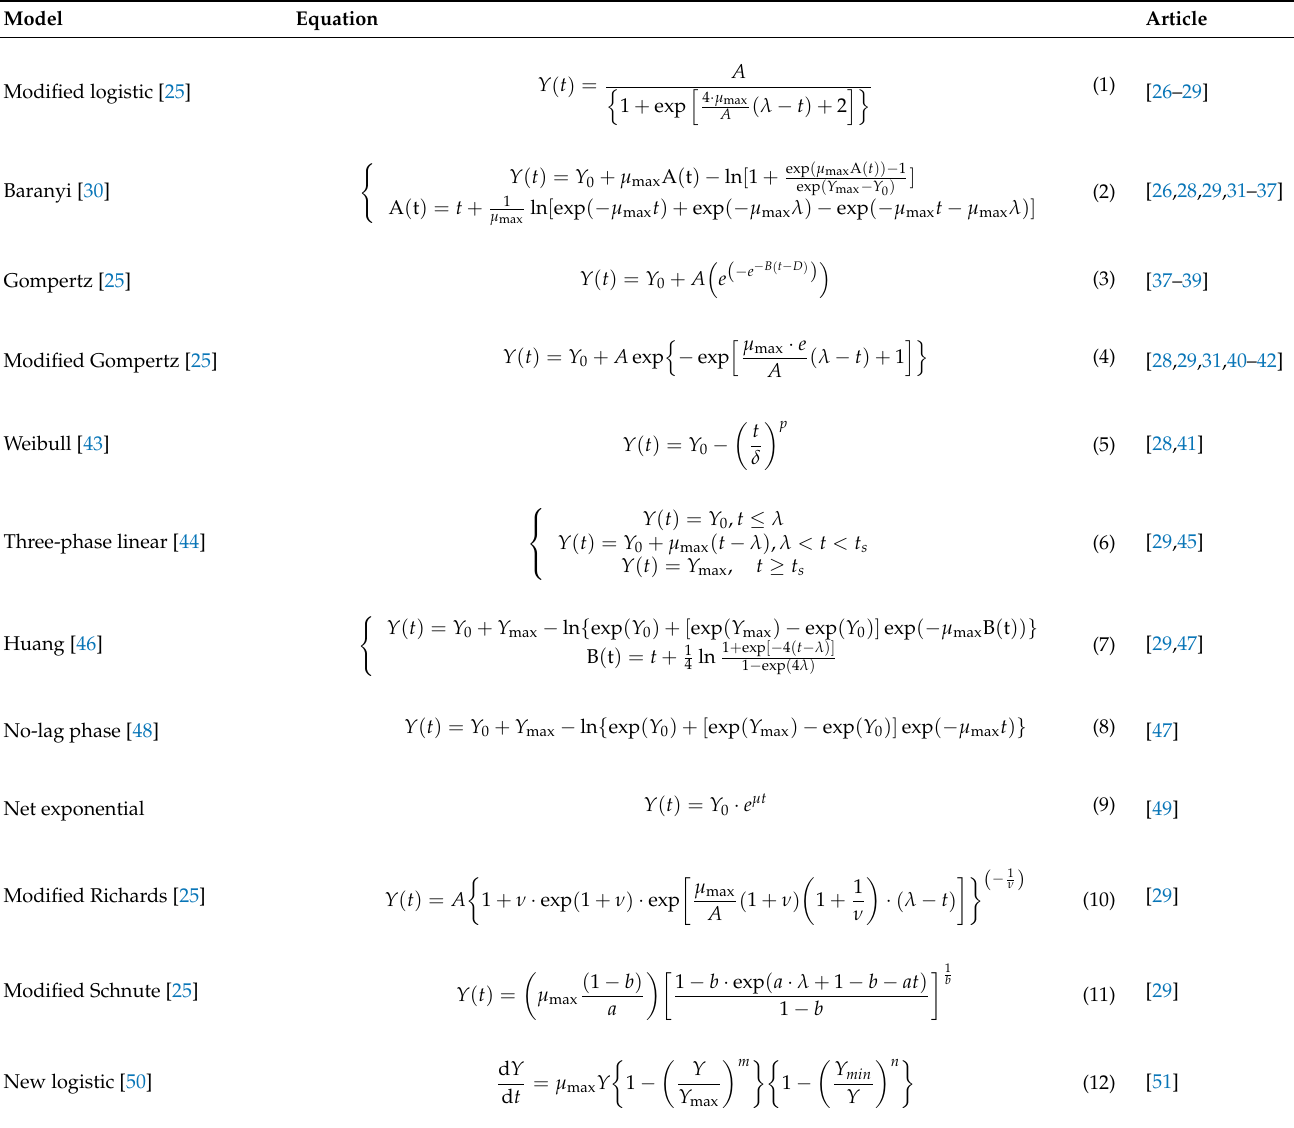
Table 1. Systematized equations for Vibrio spp. primary growth models. Of the 12 models listed in this table, one (new logistic model) did not have parameters listed, so only the remaining 11 were used in further analysis. The reference in the column “Model” is the original paper containing the equation. The column “Article” lists all published articles that used the given primary